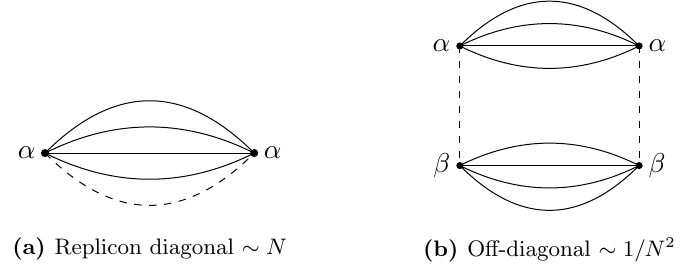
Figure 3. Replicon diagonal v.s. o(cid:11)-diagonal contributions to the partition function Z n : solid lines connects same replica index. Di(cid:11)erent replica indices can be connected only by dashed lines, which are disorder (cid:12)elds. The replicon o(cid:11)-diagonal diagram on the right is suppressed by 1 =N 3 compared to the diagonal diagram on the